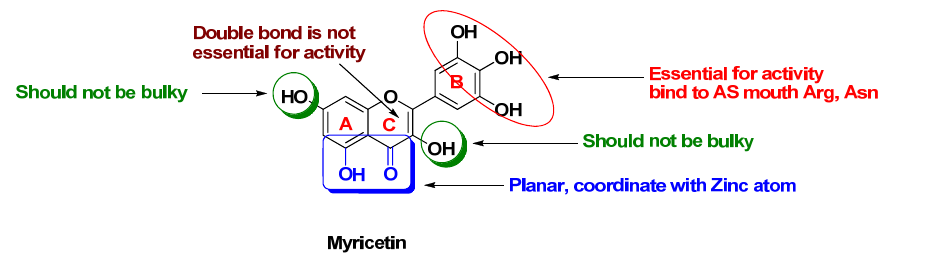
Figure 3. Takasawa vision of the expected pharmacophore and the SAR of flavonoids binding to